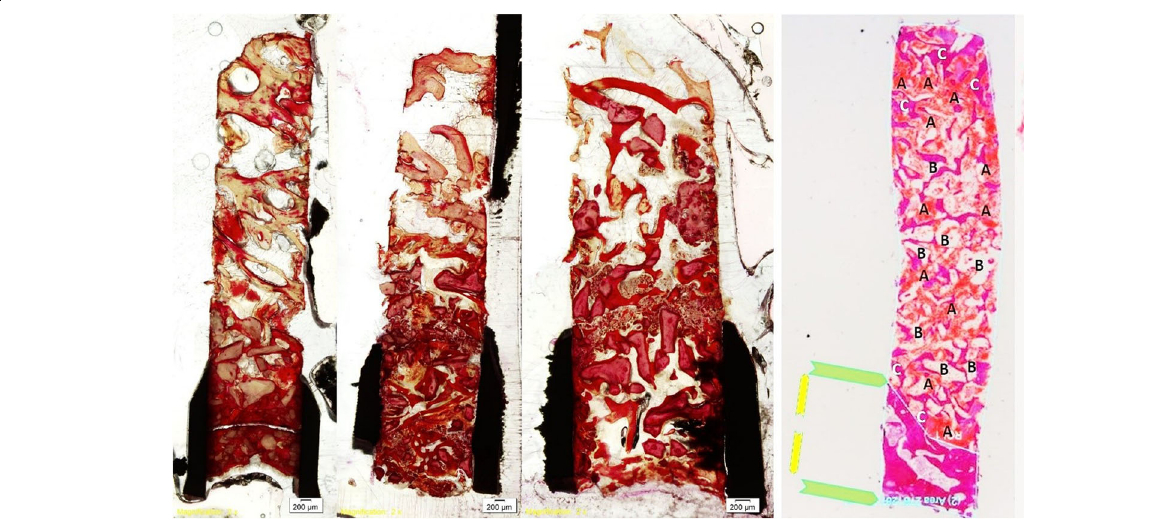
Fig. 4 The margin of pristine bone and augmented tissues was identified, and the various tissue components within the augmented area were semi-automatically estimated by dedicated image analysis software. Newly formed bone, connective tissue, DBB, within the augmented area, were identified and